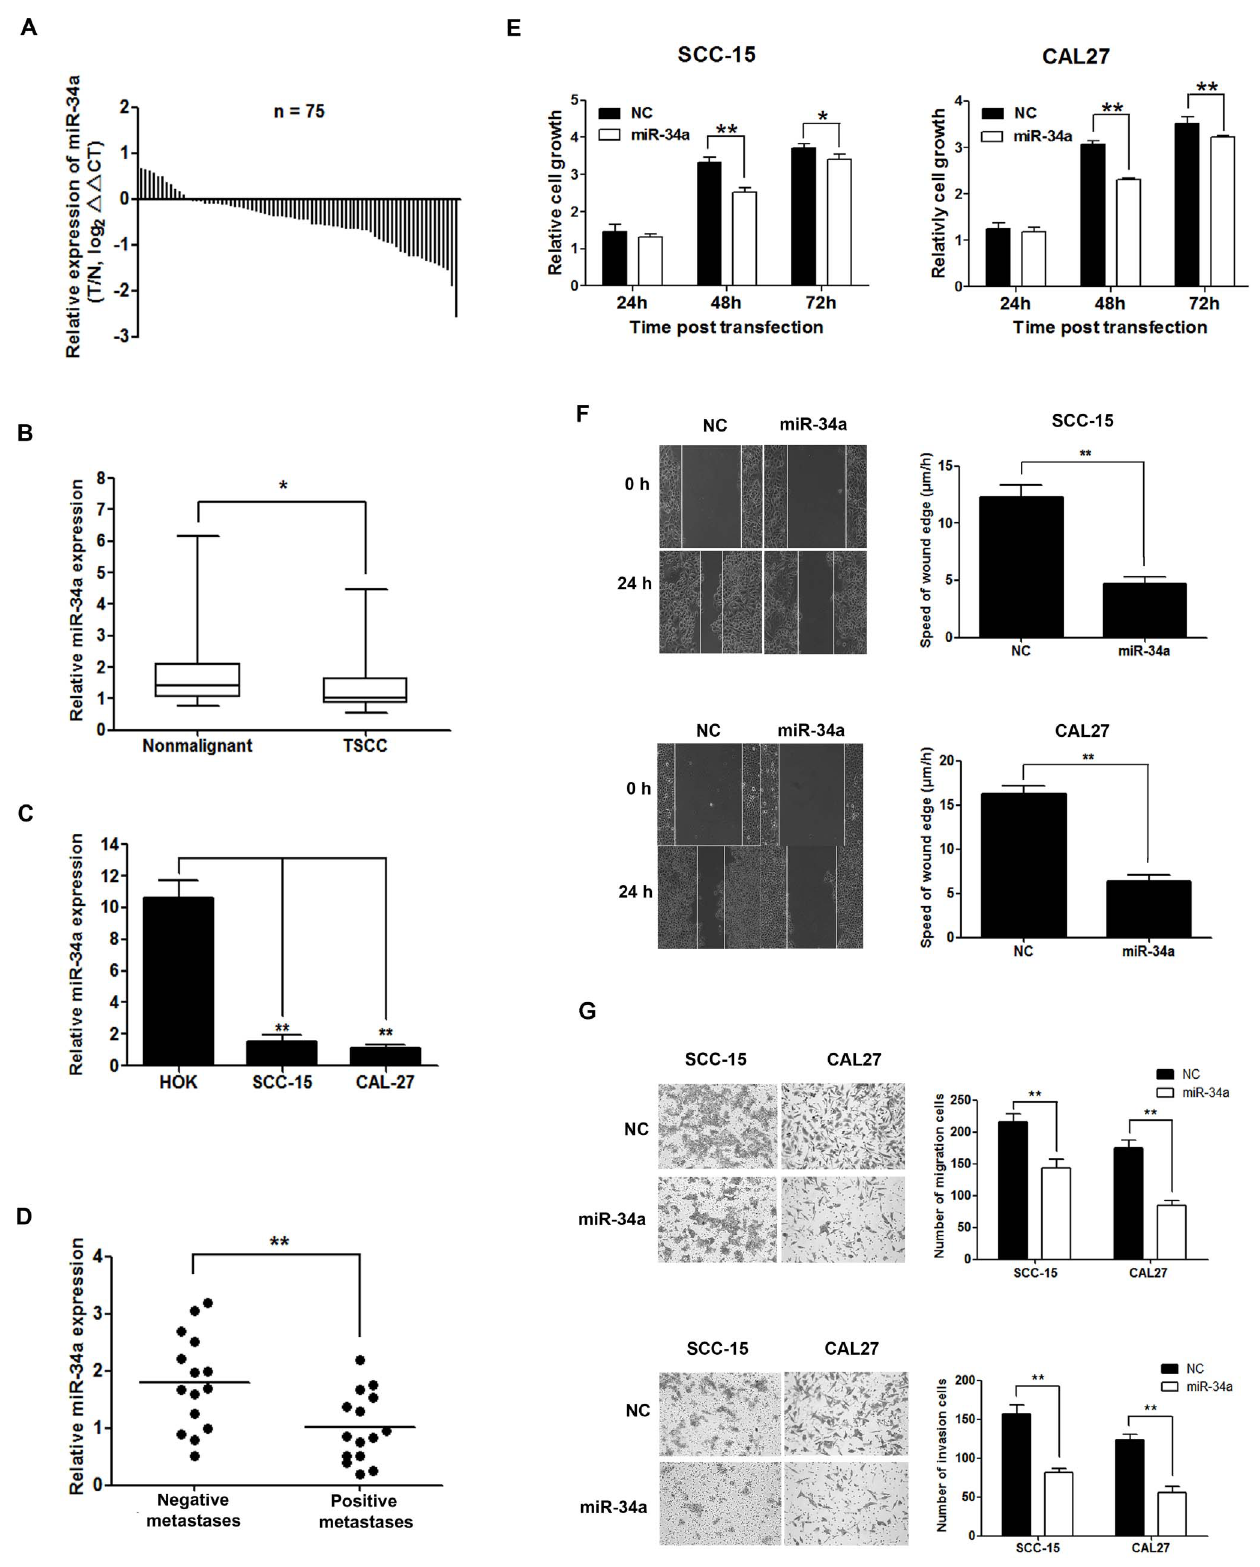
Figure 1. miR-34a correlated with lymph node metastases of TSCC patients and inhibited migration and invasion of TSCC cell lines. (A), Relative levels of miR-34a in 75 surgical specimens of TSCC and matched adjacent nonmalignant tissues was quantified by qRT-PCR. Data were presented as log2 fold change( gg Ct values,TSCC/Nonmalignant, T/N). (B), Means of miR-34a relative levels for 75 surgical specimens of TSCC and the matched adjacent nonmalignant tissues. Data were presented as 2 2 g Ct (miR-34a-U6) values (* P , 0.05). (C), Means of miR-34a relative levels in SCC-15,